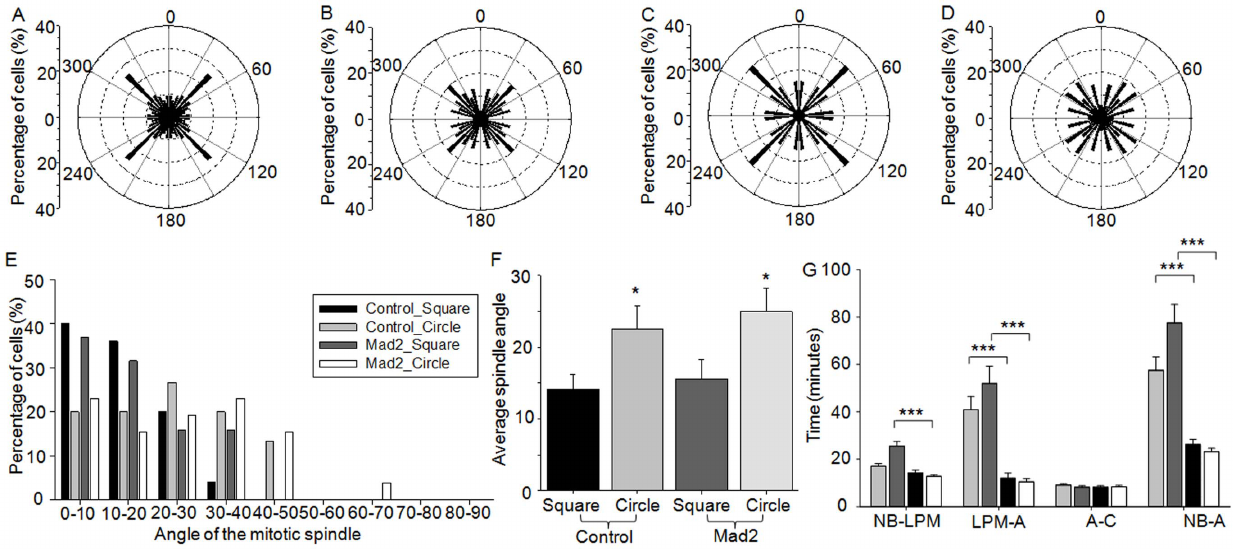
Figure 4. The role of spindle checkpoint activation in the shape dependent differences in mitosis. HeLa (GFP-H2B/RFP-tubulin) cells were assessed for the parallel orientation of the mitotic spindle at metaphase after transfection with (A and B) scrambled siRNA or (C and D) Mad2 siRNA and culture in (A and C) square or (B and D) circular microwells to determine the role of spindle checkpoint activation. Cells cultured in circular microwells showed a random orientation of the mitotic spindle, whilst cells cultured in square microwells predominately aligned the spindle along the long axis of the cell, regardless of the depletion of Mad2. Similarly, the depletion of Mad2 had little effect on (E) the distribution and (F) average spindle orientation perpendicular to the substrate plane. Values represent spindle angle in degrees 6 SEM. (G) Cells transfected with siRNA for Mad2 and cultured in circular microwells (white bars) took significantly less time to reach late prometaphase than cells transfected with control siRNA (dark grey bars), indicating that the shape dependent effect on the time required to reach late prometaphase was due to differences in spindle checkpoint activation. All values represent time in minutes 6 SEM. Key: * p , 0.05, *** p , 0.001; NB = nuclear envelope breakdown, LPM = late prometaphase, M= metaphase, A= anaphase, C=